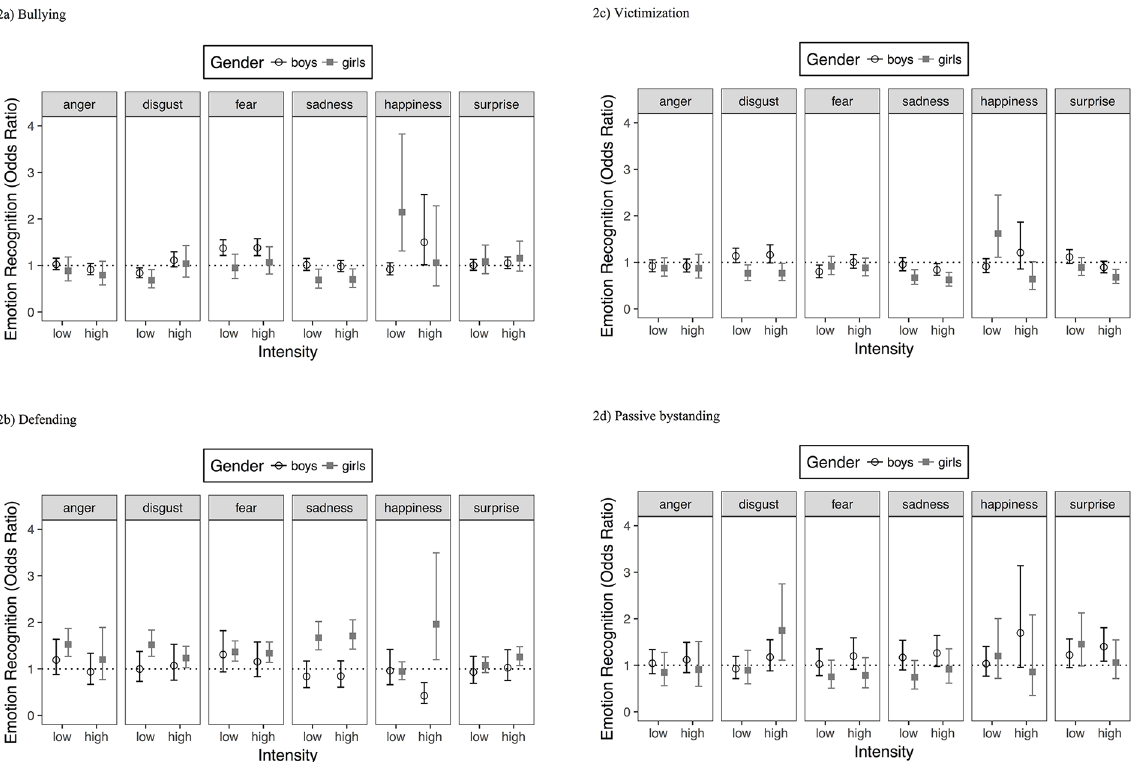
Fig 2. Estimated Odds Ratios representing the relative variation in the odds of emotion recognition accuracyfor a 10% increaseof bullying/ /victimization/ defending/passive bystanding score. Error bars represent 95% Bayesiancredibleintervals (n subjects = 117, n observations =